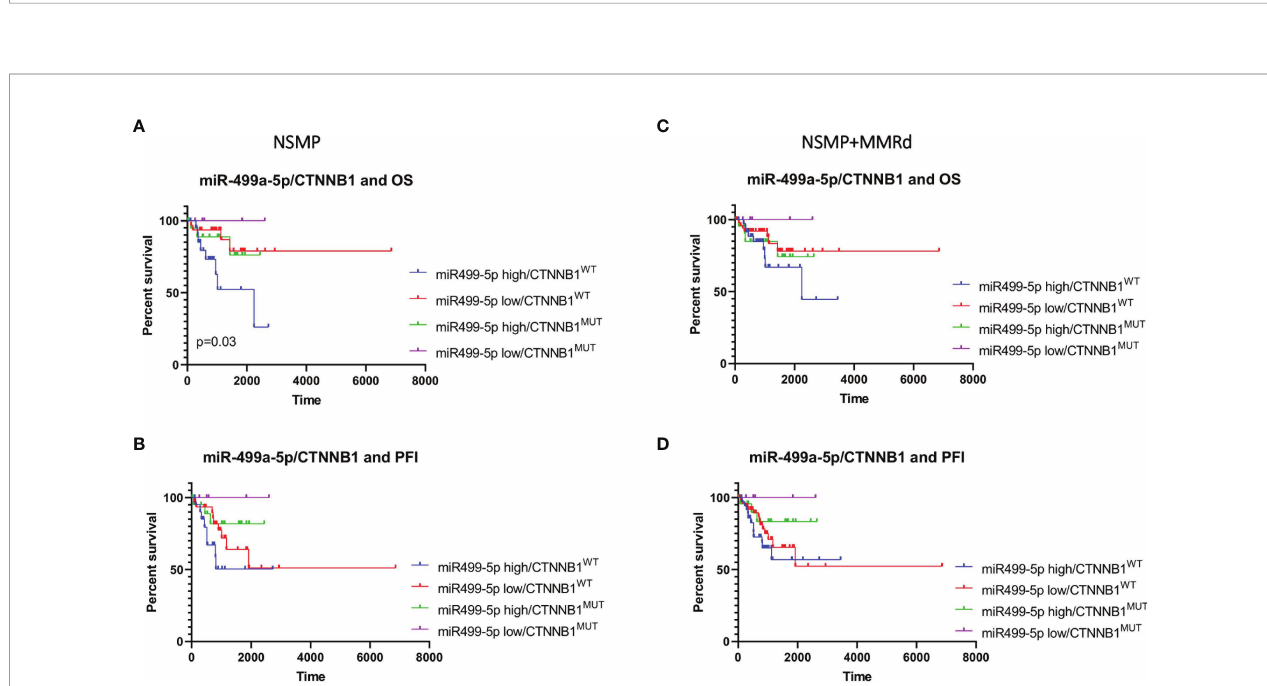
FIGURE 5 | Kaplan – Meier estimates of OS (A, C) and PFI (B, D) in NSMP alone and NSMP + MMRd groups, based on the combination of miR-499a-5p expression and CTNNB1